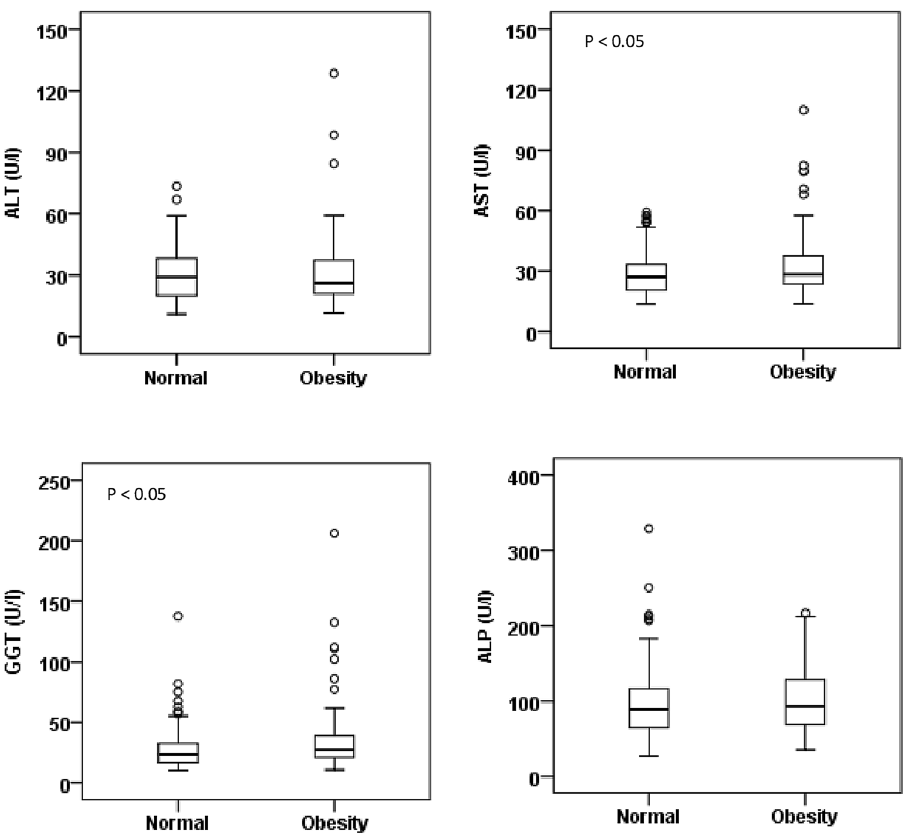
Figure 2. Levels of serum liver enzymes in the WC groups (n = 296 in normal and n = 244 in obesity group). P-values are obtained from independent sample t-test. *P < 0.05 when the mean level of liver enzymes in the normal group is compared to the obesity group.